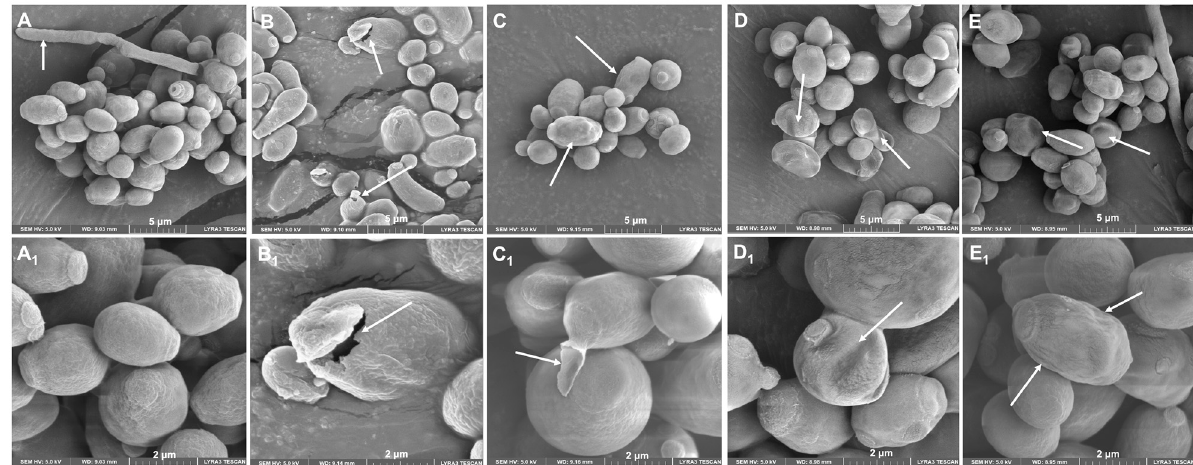
Figure 7. The effect of LL-37 analog peptides (AC-1, AC-2, LL37-1, and D) on C. albicans ATCC 10231 structure. SEM micrographs showed that yeasts treated with analog peptides had perturbations on their wall: ( A ) yeast in the absence of peptide; ( B ) treated with analog peptide AC1; ( C ) treated with analog peptide AC2; ( D ) treated with analog peptide LL37-1; and ( E ) treated with analog peptide D. Images ( A – E ) were taken at 5 µm magnification; images ( A 1 – E 1 ) were taken at 2 µm magnification. White arrows show the damage caused to the yeasts.